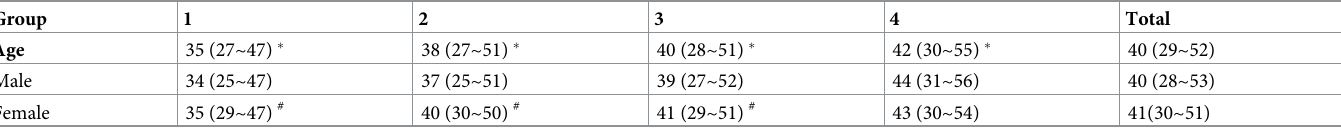
Table 2. Comparison of the ages of different sexes in each group. Group